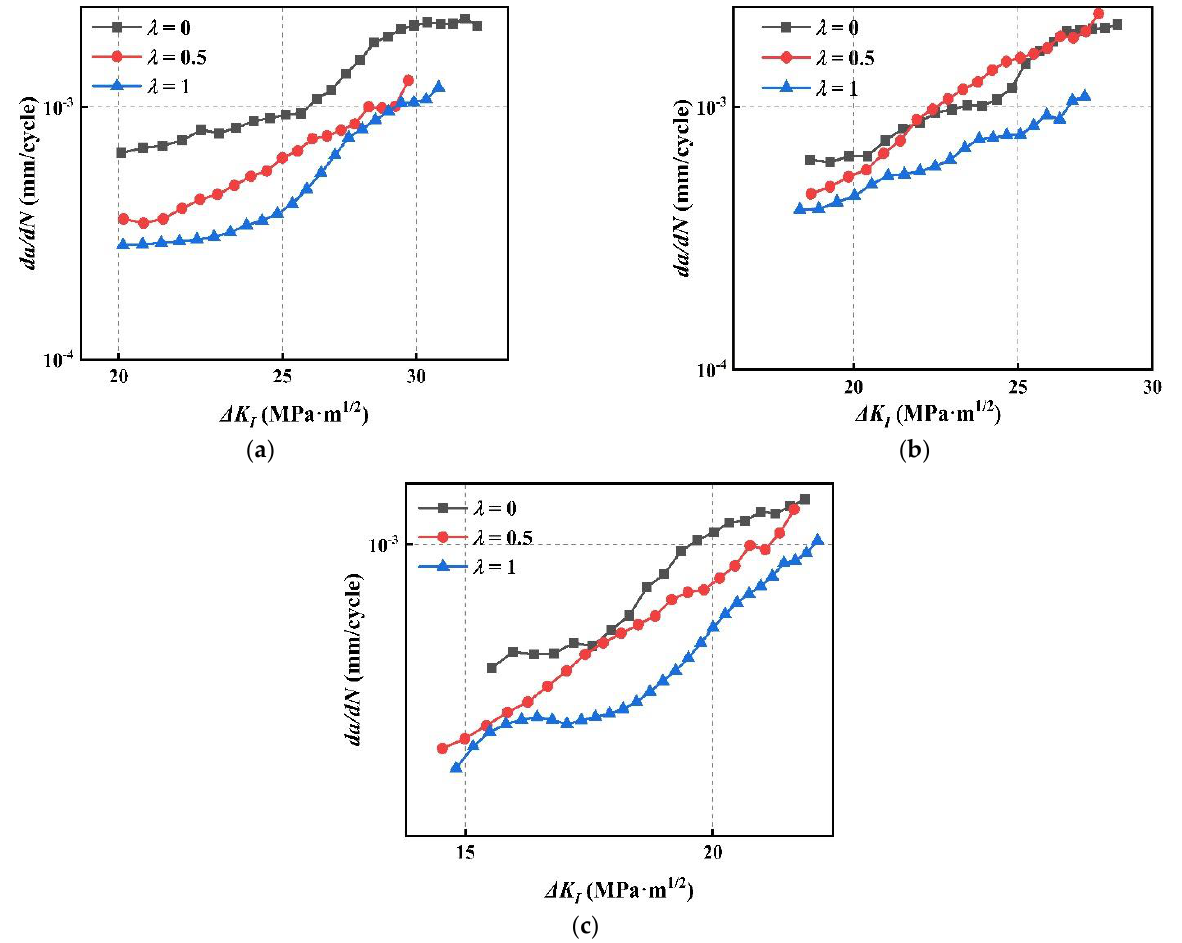
Figure 11. Where β = 90°, the relationship between FCGR and ∆ K I under different stress ratios ( a ) R = 0 ( b ) R = 0.1 ( c ) R = 0.3.